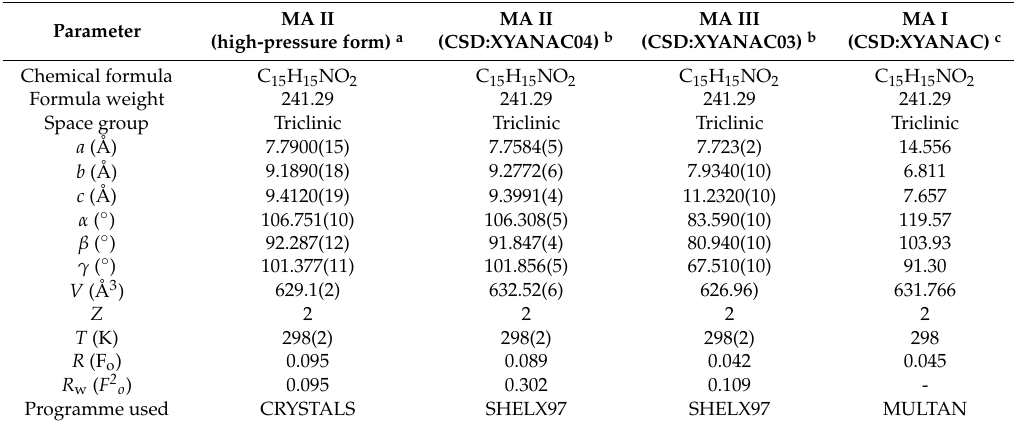
Table 2. Crystallographic information of various polymorphs of mefenamic acid (MA) compared with high-pressure structure.